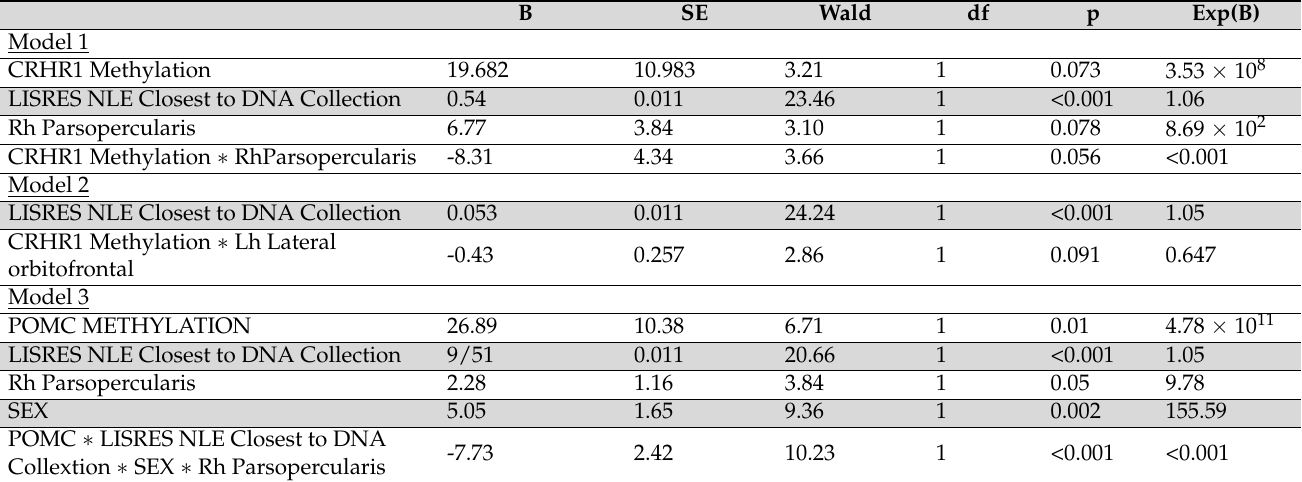
Table 7. Cox Regression-SUD Survival (N = 217) with CHRH1 methylation, POMC methylation, Negative Life Events, parsopercularis, and lateralorbital cortical thickness. B SE Wald